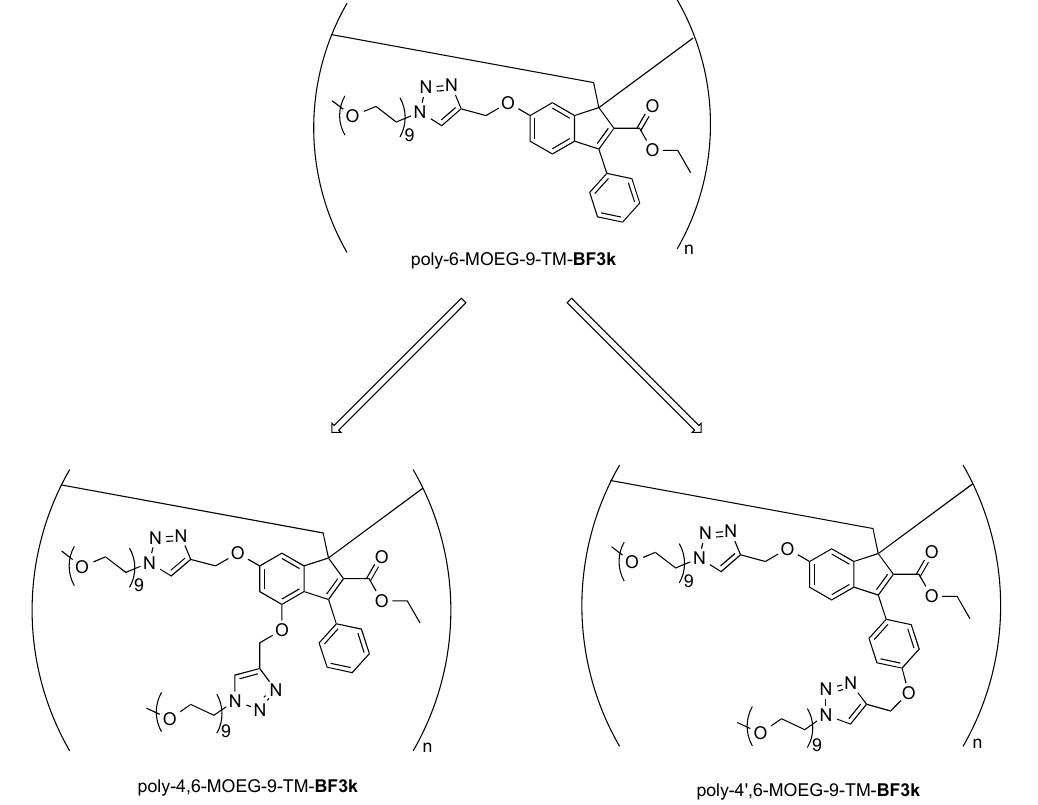
Figure 2. Design of PPBFB poly-4,6-MOEG-9-TM- BF3k and poly-4’,6-MOEG-9-TM- BF3k by the introduction of a second water-solubilizing MOEG-9 in the structure of poly-6-MOEG-9-TM- BF3k monomeric unit.